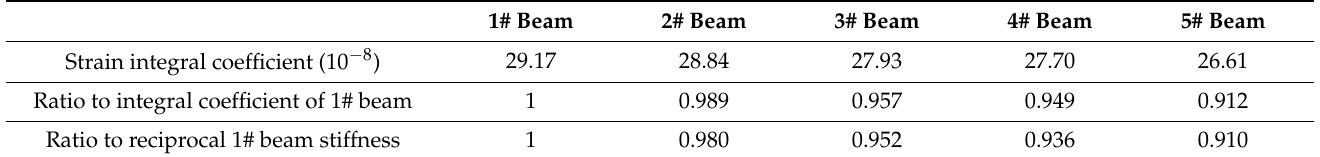
Table 2. The mid-span strain integral coefficient of each beam bottom.